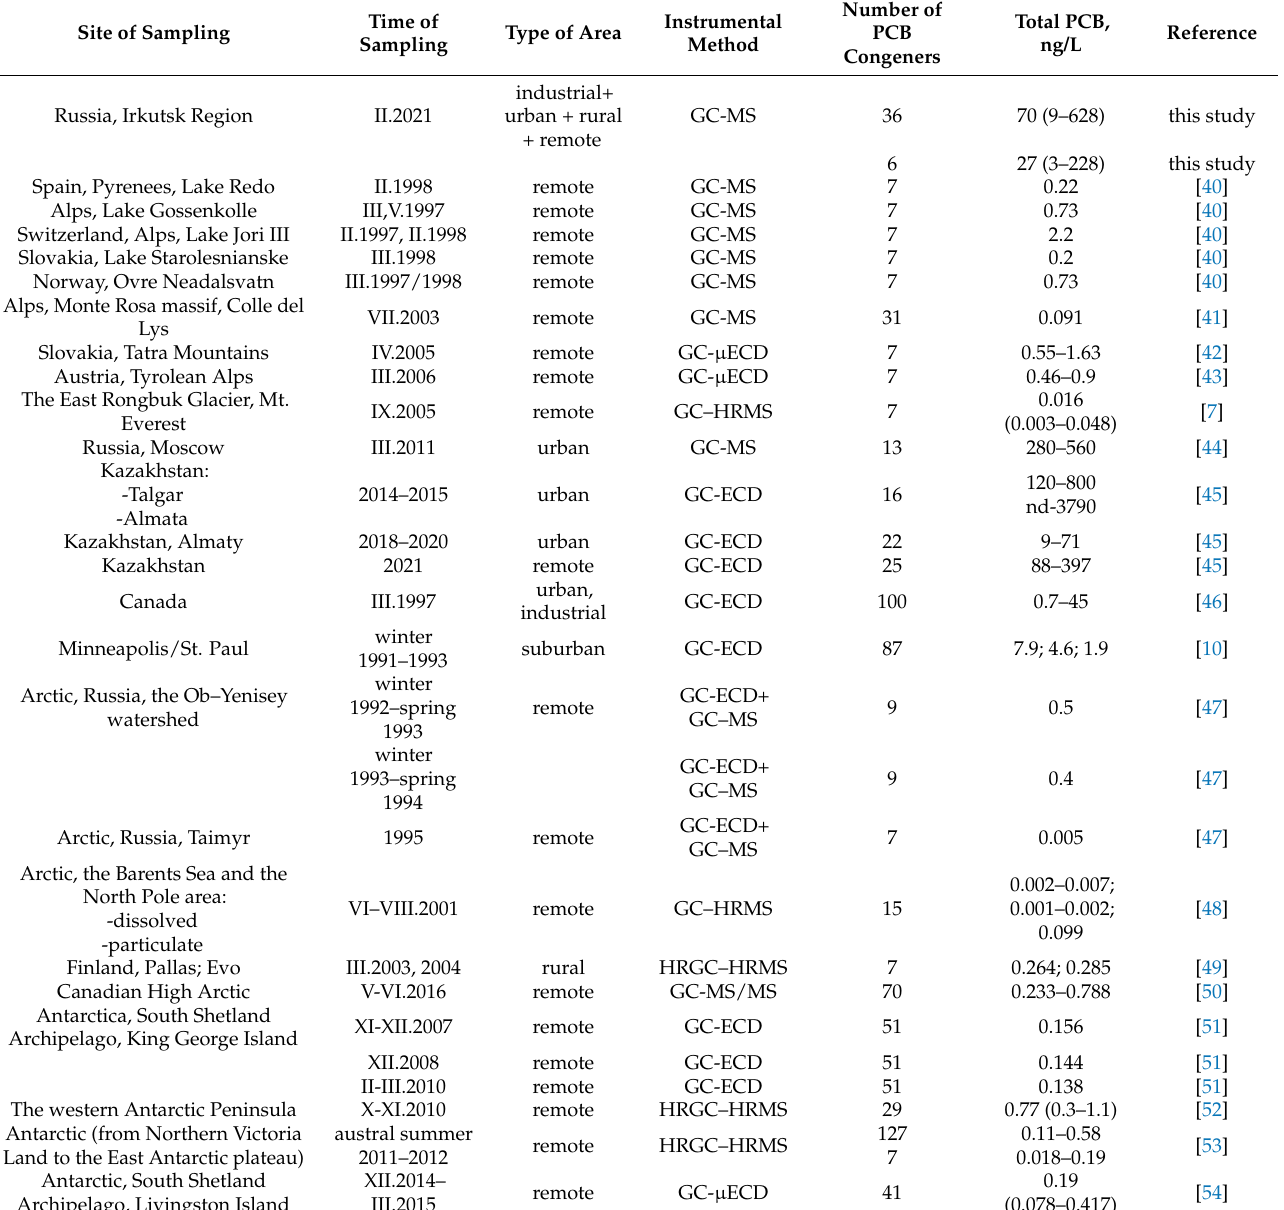
Table 2. The comparison of PCB levels in snow water from different areas of the